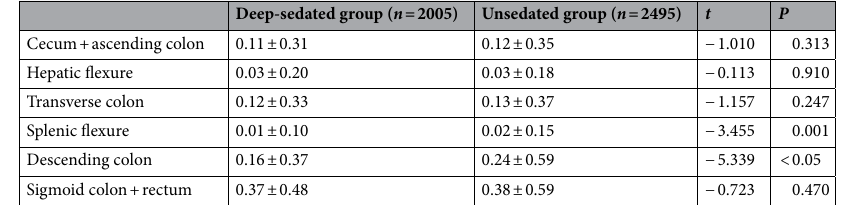
Table 4. Comparison of average number of adenomas detected in different colorectal segments.